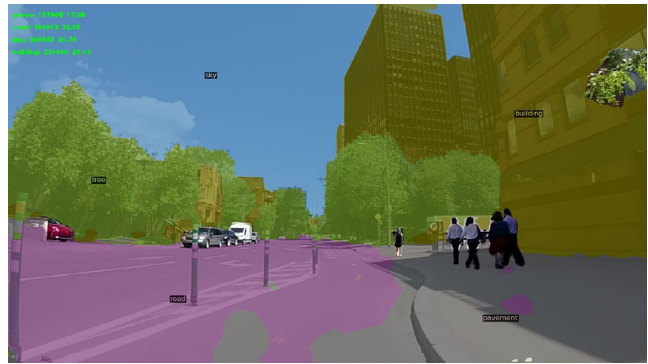
Figure 3. Segmented image; 17.08% of image pixels were classified as